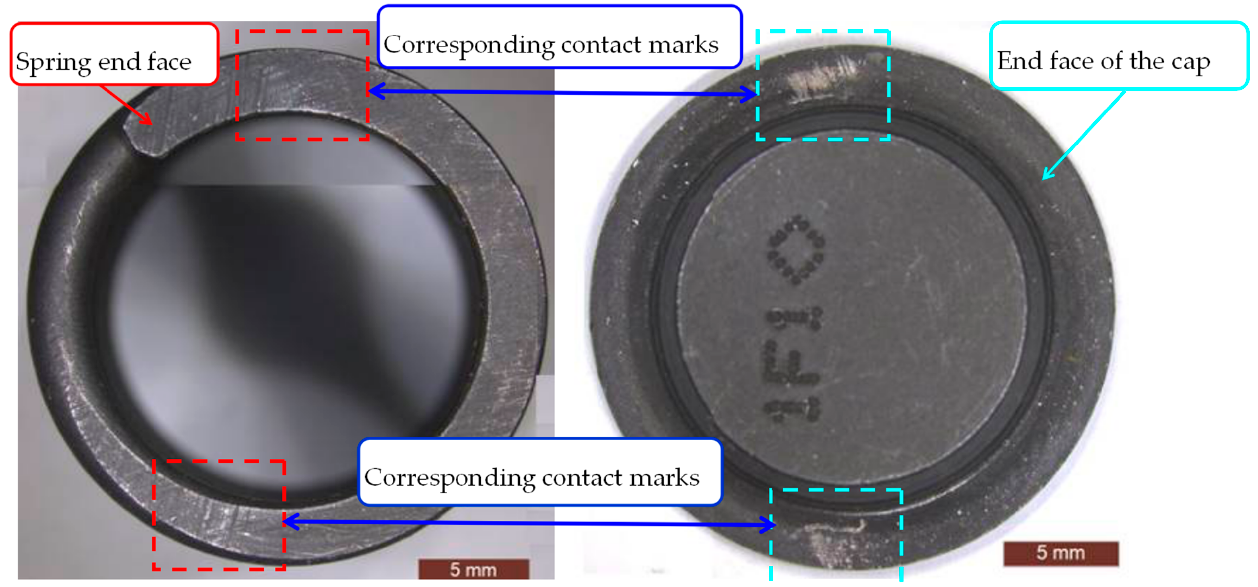
Figure 15. Two contact marks in the end face of the spring and the cap.